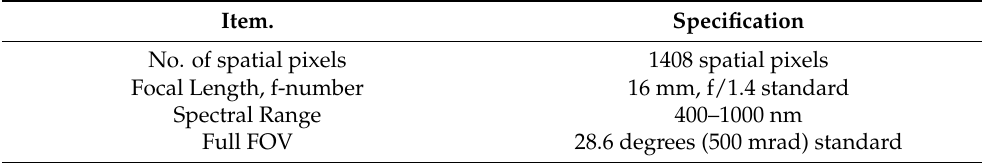
Table 1. MicroHSI™ 410-SHARK specifications.